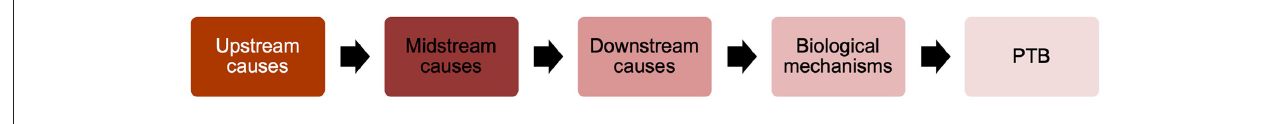
FIGURE 1 | Potential causes of the Black-White disparity in PTB can be categorized by the hypothesized proximity of their effects on